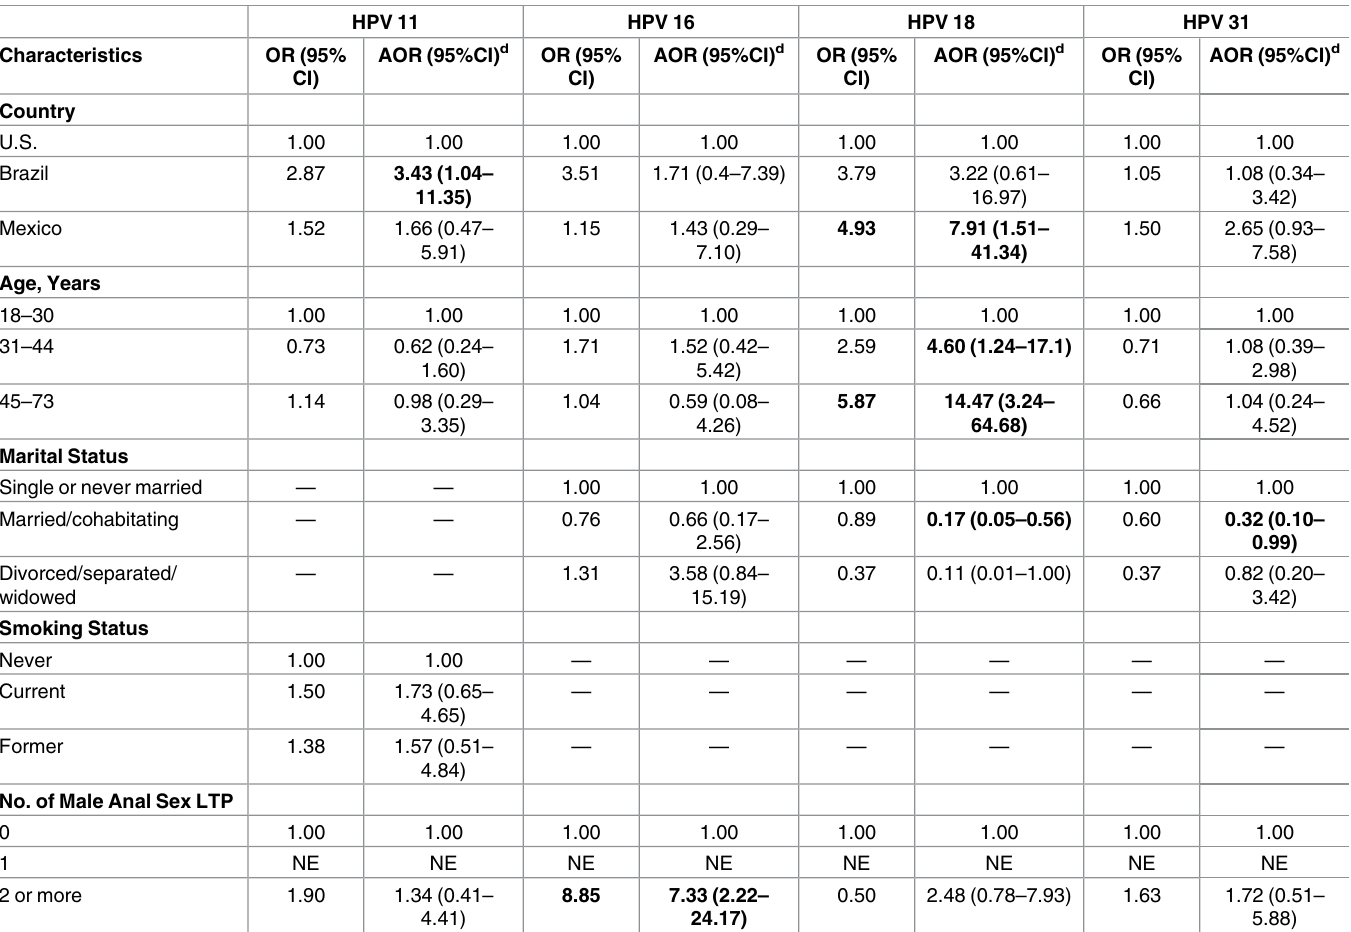
Table 4. Factors independently associated with seropositivity of nine vaccine type HPV in men from Brazil, Mexico and the United